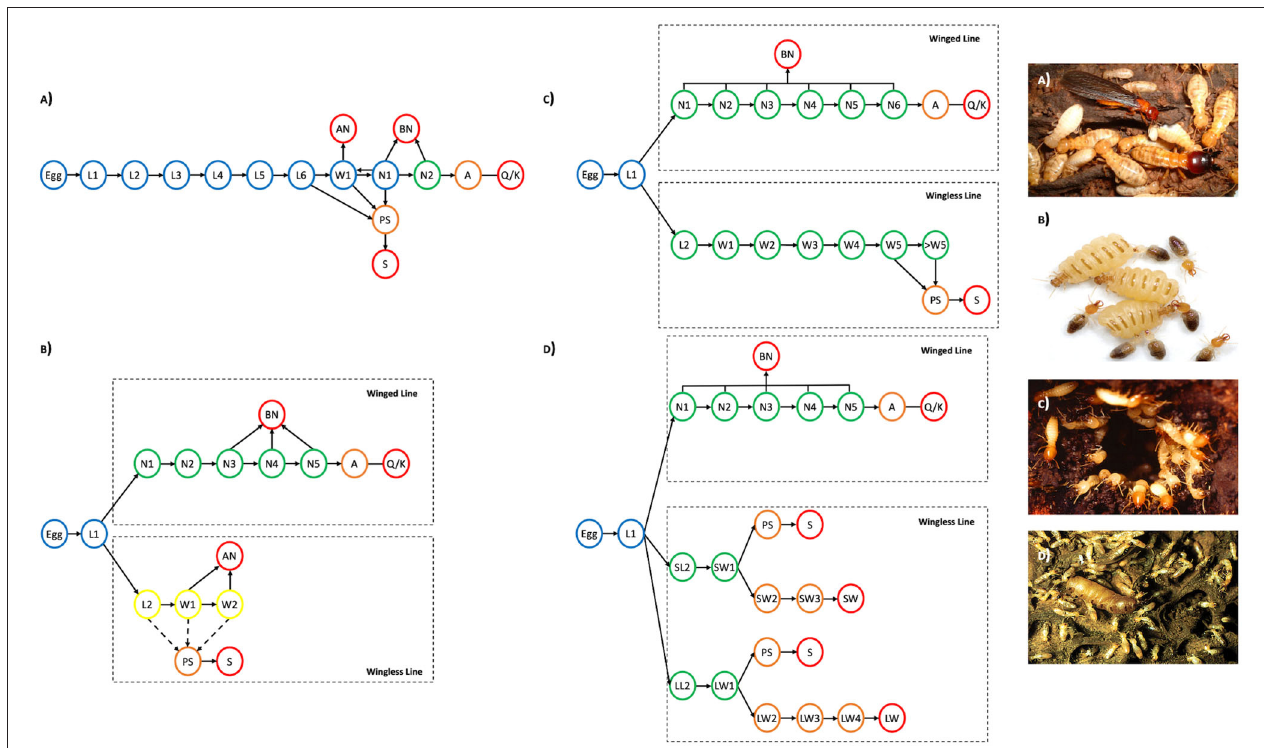
FIGURE 3 | Developmental pathways of (A) the wood-dwelling termite Hodotermopsis sjostedti , Modified after (Miura et al., 2000); (B) Females in the foraging termite Silvestritermes euamignathus (both solid and dashed arrows) and males in the foraging termite Silvestritermes euamignathus (only solid arrows), Modified after (Haifig and Costa-Leonardo, 2016 ); (C) females in the foraging termite Coptotermes lacteus , Modified after (Roisin and Lenz, 1999); (D) the foraging termite Microcerotermes beesoni , Modified after ( Rasib and Akhtar, 2012). Arrows symbolize molts. Forward arrows, progressive molts; Backward arrows, Regressive molts; dashed lines; only one sex can molt into this phenotype. Lines symbolize morphological and physiological change without molt. L1, Larval instar 1; W1, worker instar 1; N1, nymphal instar 1; AN, Apterous Neotenic; BN, Brachypterous Neotenic; A, alate; PS, presoldier; S, soldier; Q/K, queen/king. Blue, Totipotent; Yellow, Pluripotent; Green, Multipotent; Orange, Unipotent; Red, Committed. (photos: A ) Hodotermopsis sjostedti - https://polyphenism.wordpress.com/2006/04/01/japanese-damp-wood- termite/hodotermopsis-sjostedti/, (B) Silvestritermes minutus — Robert Hanus , (C) Coptotermes formosanus , (D) Microcerotermes — Bill Sands, NHM London collection